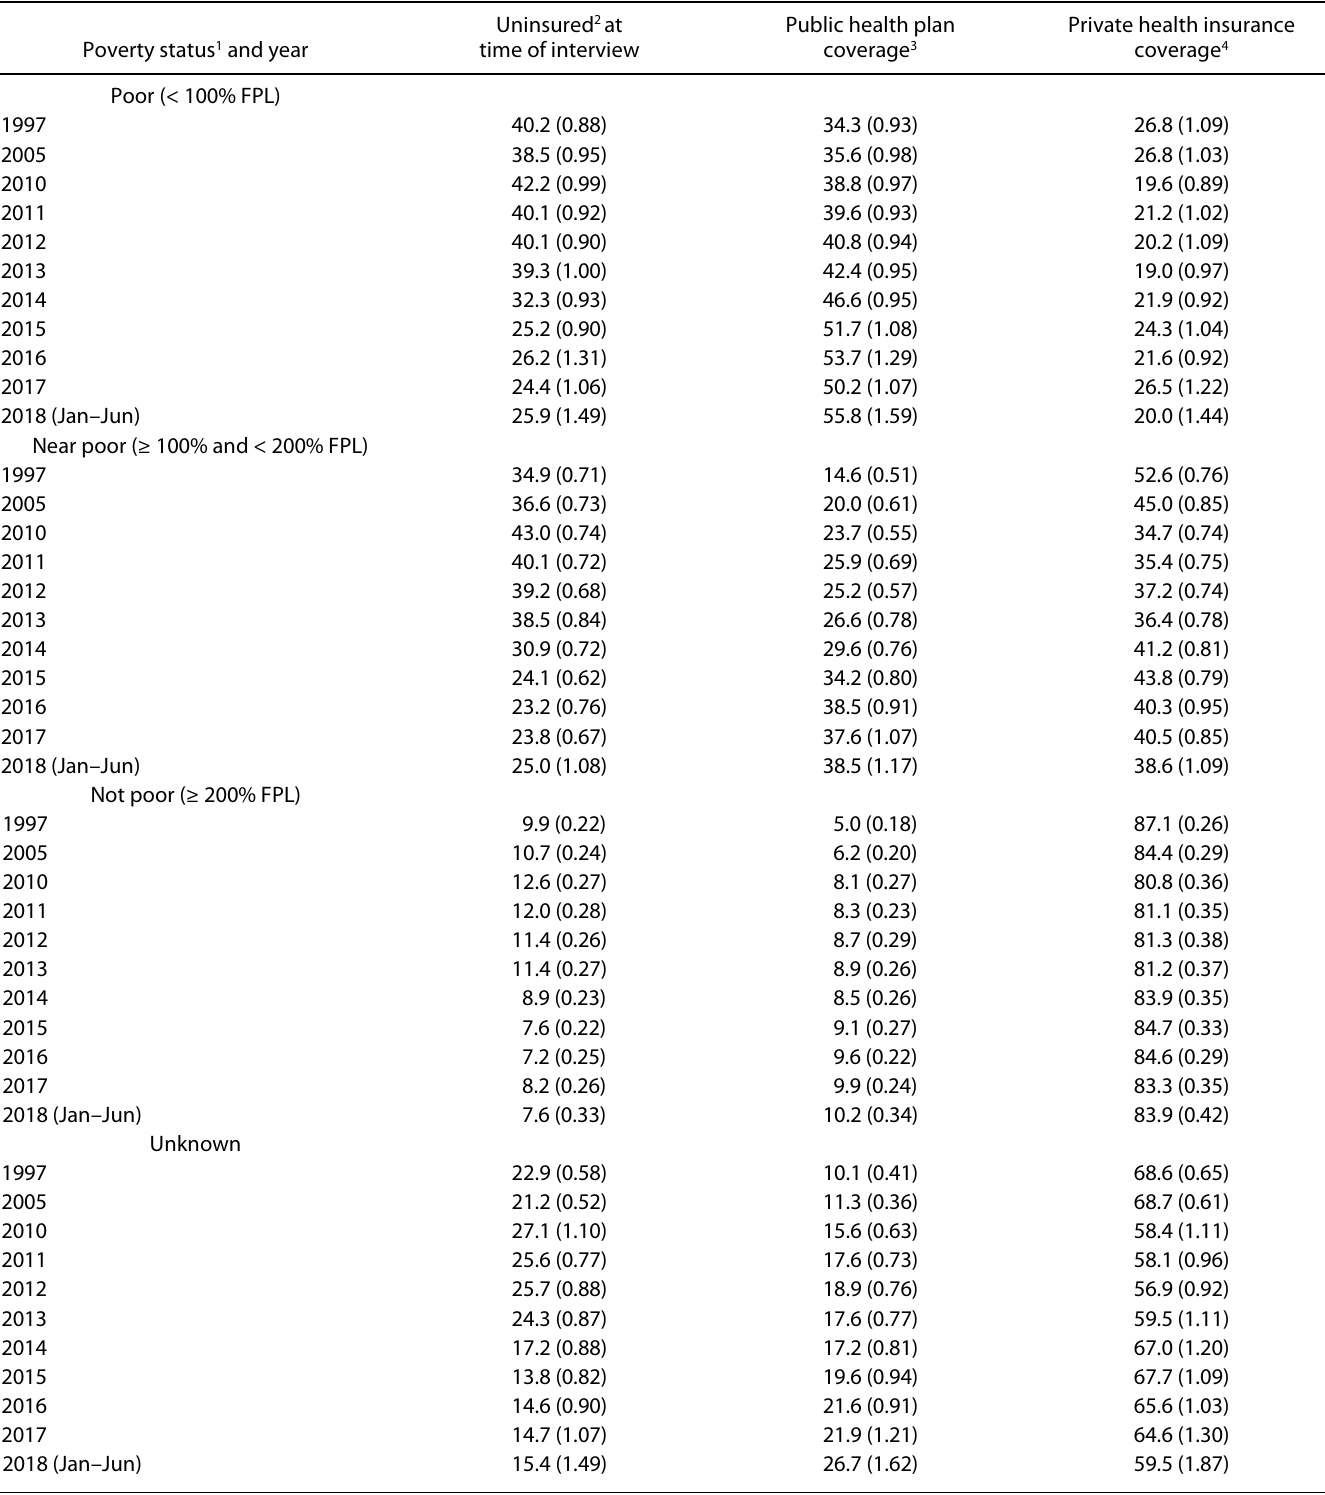
Table V. Percentages (and standard errors) of adults aged 18–64 who lacked health insurance coverage, had public health